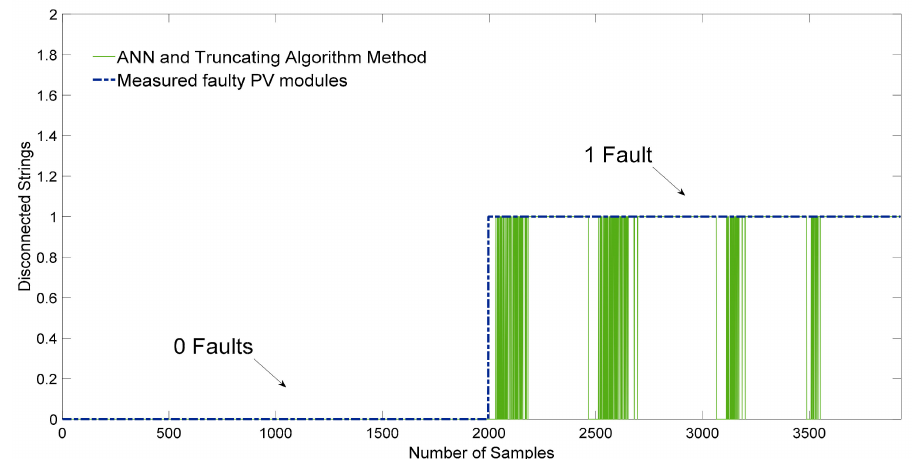
Figure 18. System 2 results using the ANN combined with a truncating algorithm.